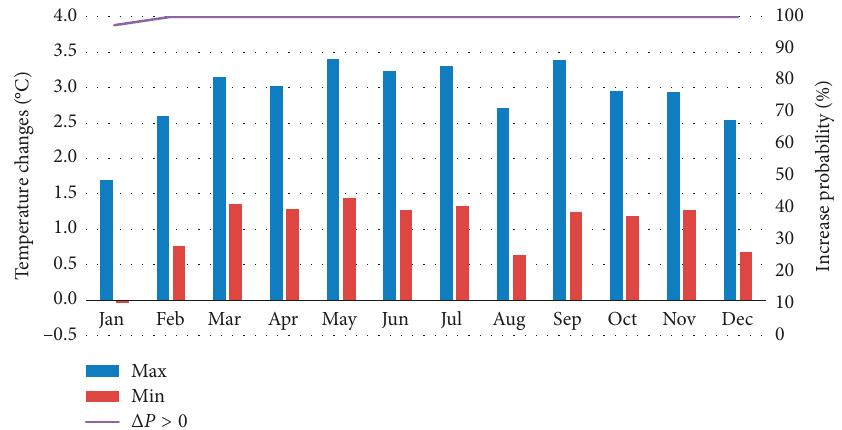
Figure 9: Range of changes in the monthly average of the minimum daily temperature in the future middle period under all models and three emission scenarios and their probabilities.